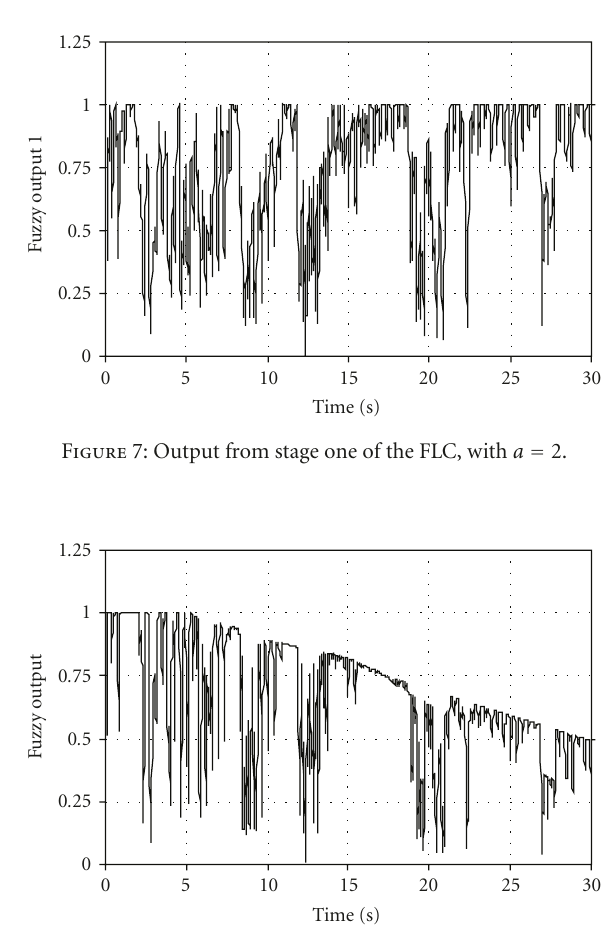
Figure 10: Delay input to stage one of the FLC, with a = 2.